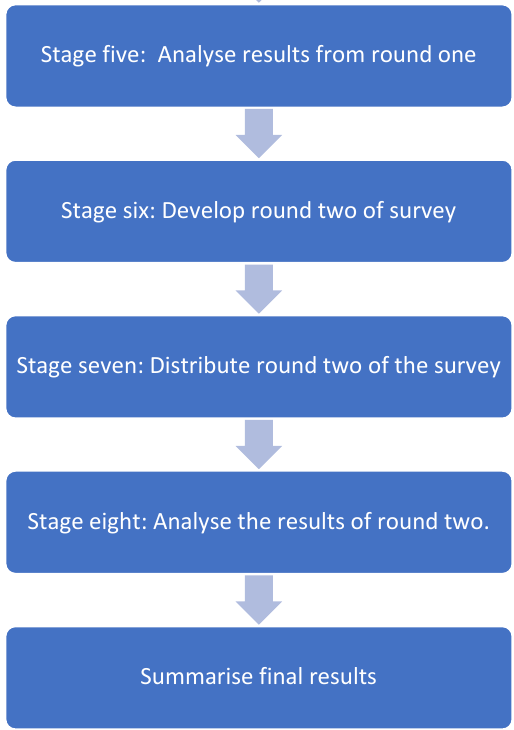
Figure 1. Modified Delphi process.